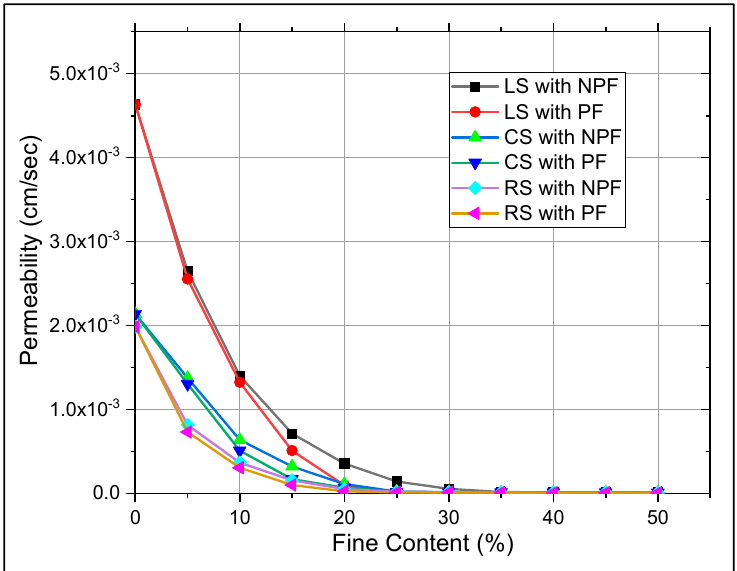
Figure 5. Variation in permeability with different fine contents.